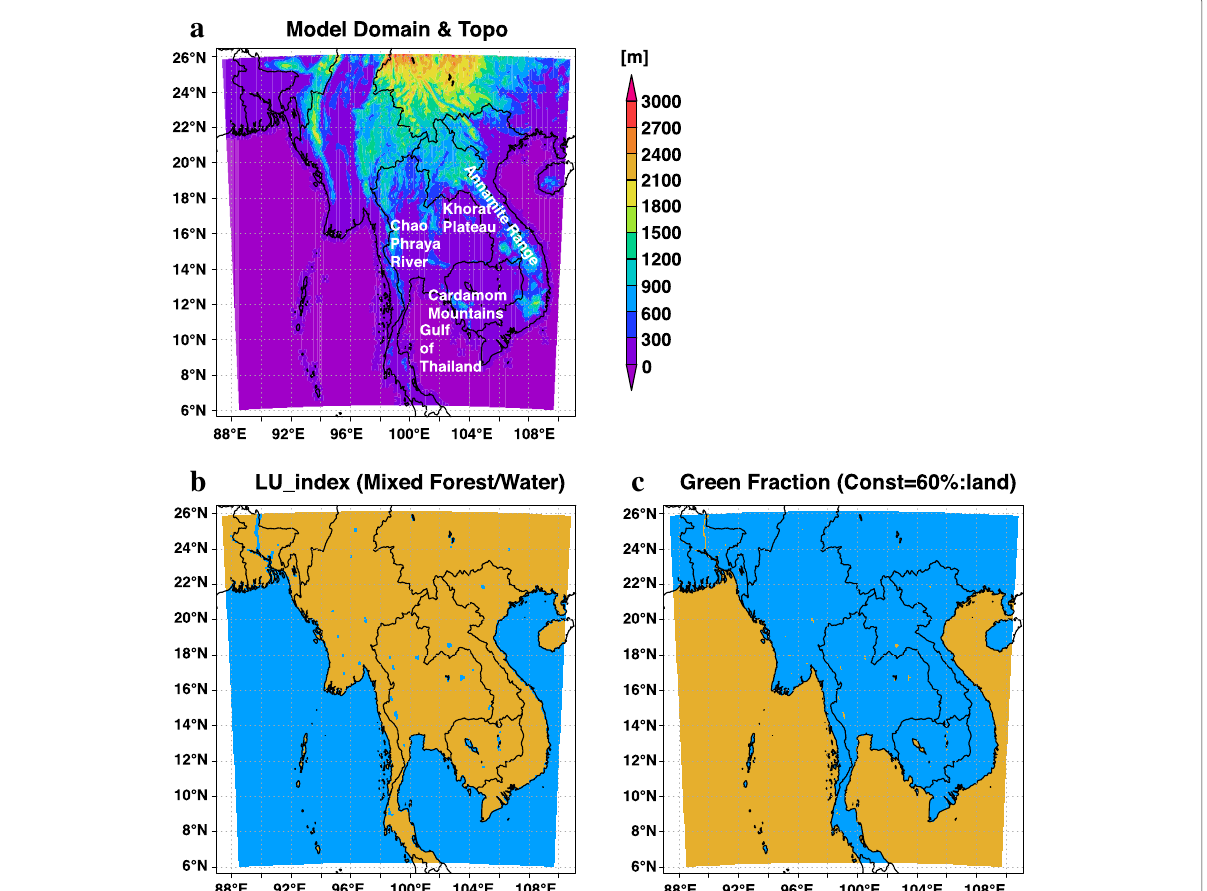
Fig. 1 a Study area, geographical names and topography in Domain 1. b Landuse index used in this simulation. For simplicity, all land uses were converted to a specific land use category except for water bodies. c Spatial distribution of the vegetation fraction, which was used in the land surface model (LSM). Differences in this parameter can affect the Bowen ratio under the same near-surface atmospheric, and soil moisture conditions. For simplicity, all values over land were unified to 0.6, which indicated that 60% of the grid area was covered by